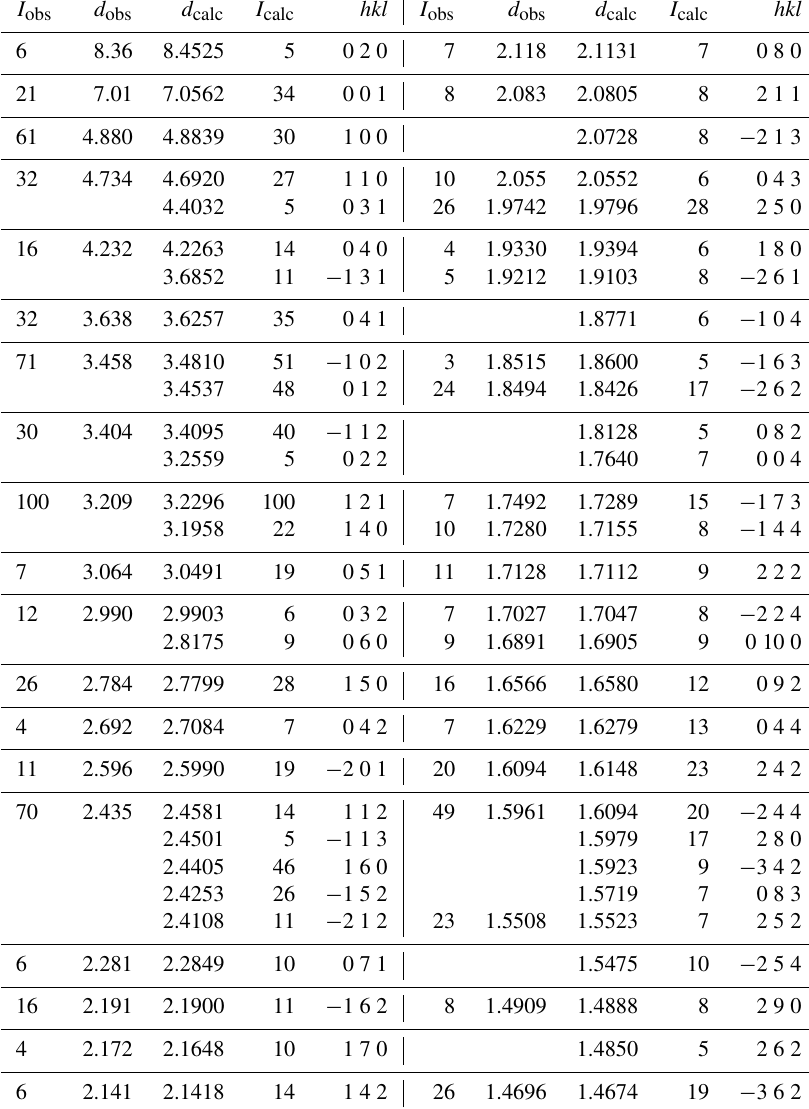
Table 3. Powder X-ray data ( d in Å) for manganrockbridgeite compared with those calculated from the structure. Only calculated lines with I ≥ 4 . 5 are